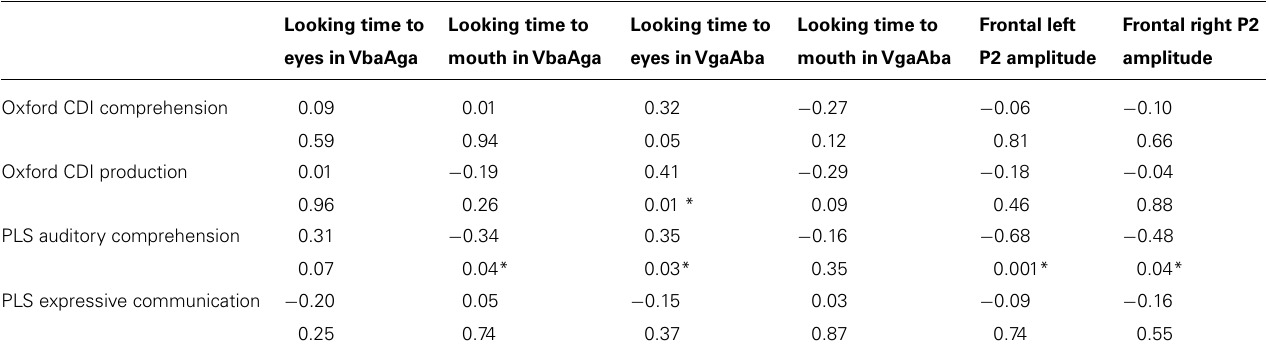
Table 2 | Partial correlations for PLS-4 and Oxford CDI scores at 14–16 months and eye-tracking and ERP measurements at 6–9 months of age (partial- r and p). Looking time